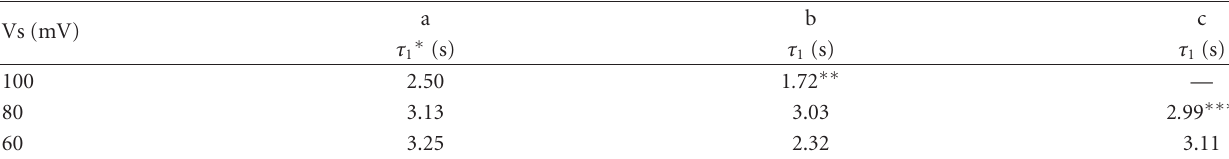
Table 2: The channel lifetime of A β P1-40 in POPC:Ch PLM. The fitted lifetime (see text) of A β P1-40 (a), A β P1-40 and choline (5 × 10 − 11 M) added to the cis / trans side of the chamber (b/c, resp.) channels in the POPC:Ch membrane. The minimum and maximum number of channels considered ( N ) out of a total number of channels considered ( N t ) was: (a) 94 < N < 240, N t = 448; (b) 120 < N <